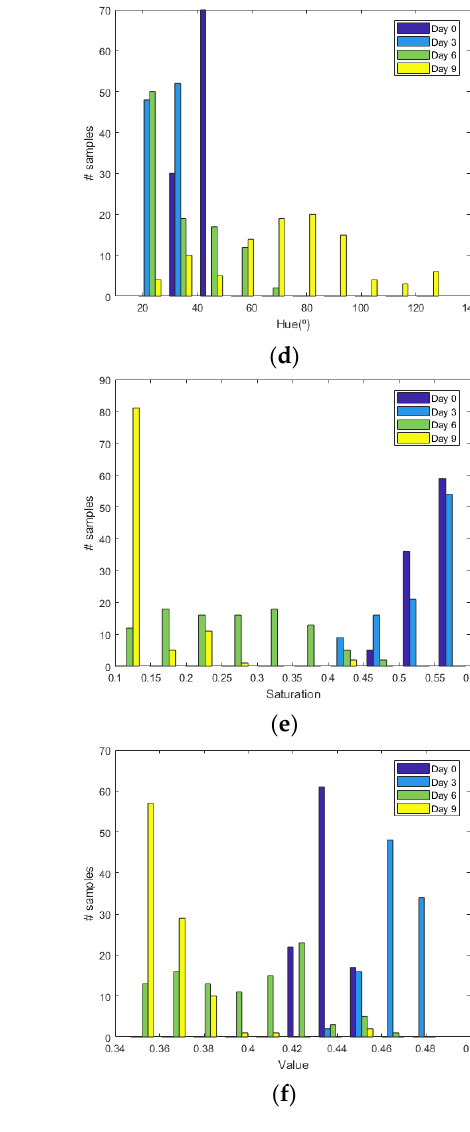
Figure 8. Histogram for a banana for different days: Histogram of the hue ( a ), saturation ( b ) and value ( c ) parameters in the fridge. Histogram of the hue ( d ), saturation ( e ) and value ( f ) parameters at room temperature.